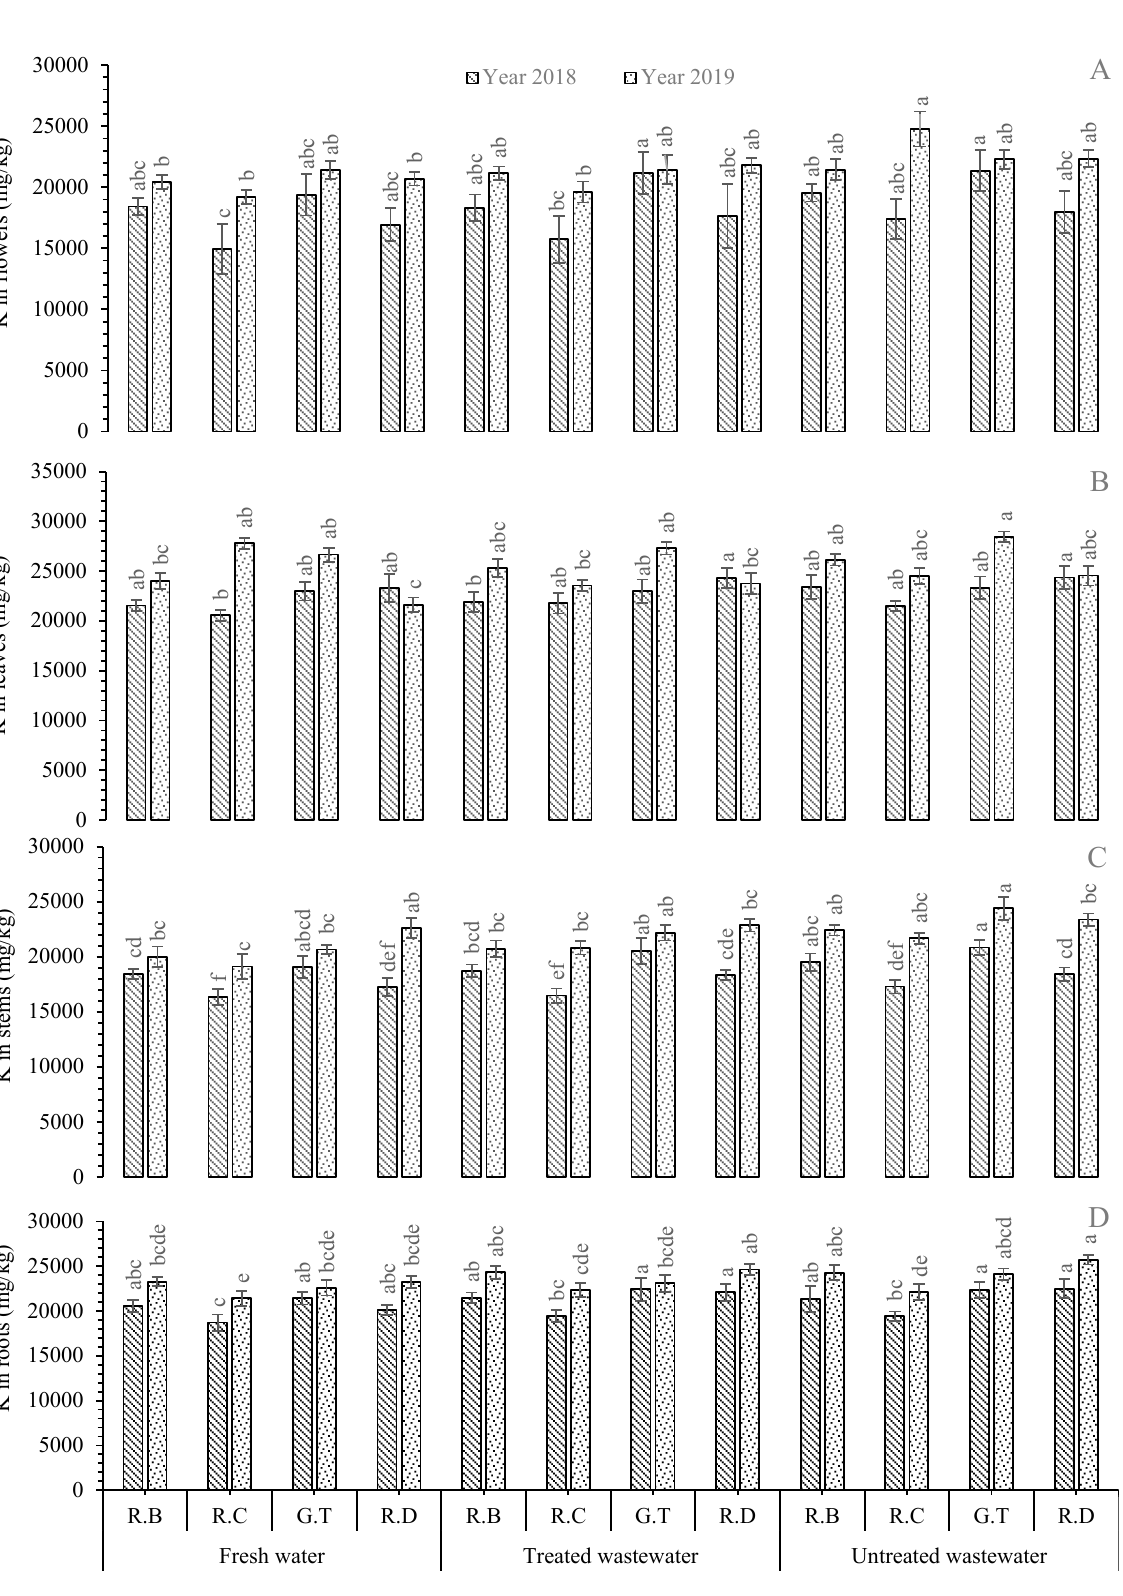
Figure 3. Mean concentration of K in plant parts, i.e., flowers ( A ), leaves ( B ), stems ( C ), and roots ( D ), of Rosa species under different irrigations. Each vertical bar represents the average of three replicates. Different letters indicate significant differences among treatments at p ≤ 0.05 according to least significant difference test. R.B: Rosa bourboniana , R.C: Rosa centifolia , G.T: Gruss-an-teplitz, R.D: Rosa damascena.